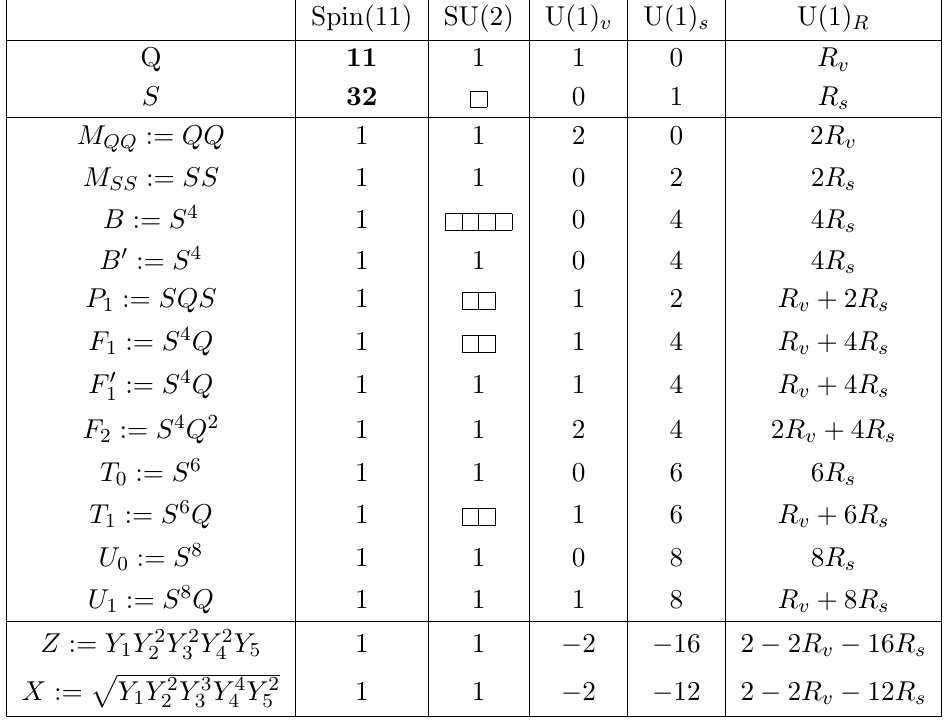
Table 19 . 3d N = 2 Spin(11) theory with ( N v ; N s ) = (1 ;